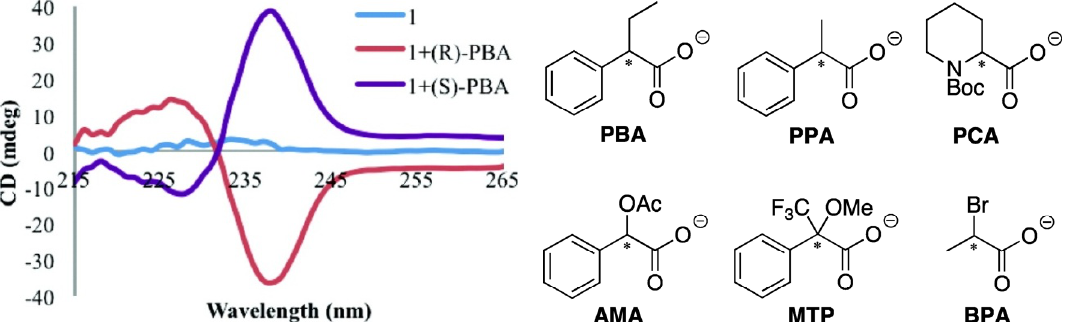
Figure 2. Left : CD spectra of Cu(II) complex of BQPA (complex 1 , 0.5 mM) by itself and with each enantiomer of PBA (1.0 mM) in 75% MeCN/H pH 7.4 [23]. Right : Structures of PBA and other analytes. Reproduced by permission of the American Chemical